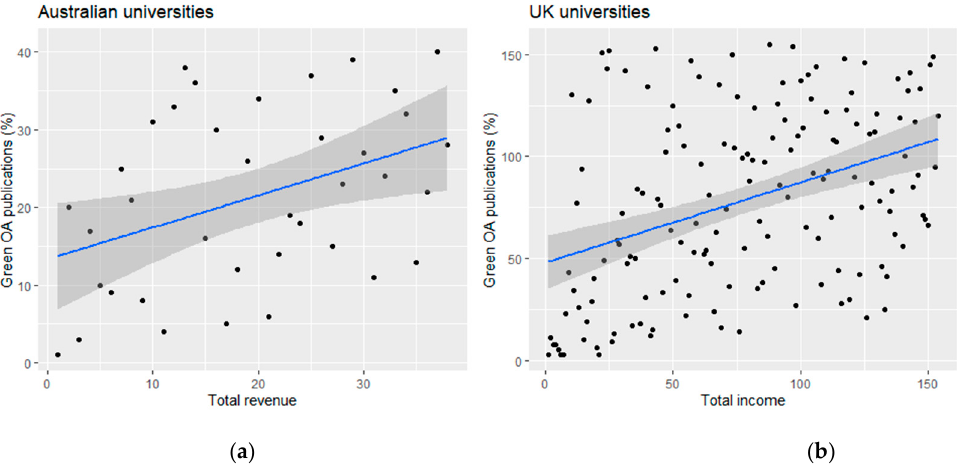
Figure A2. Scatterplot shows correlations between percentages of Green (repository) OA publica-